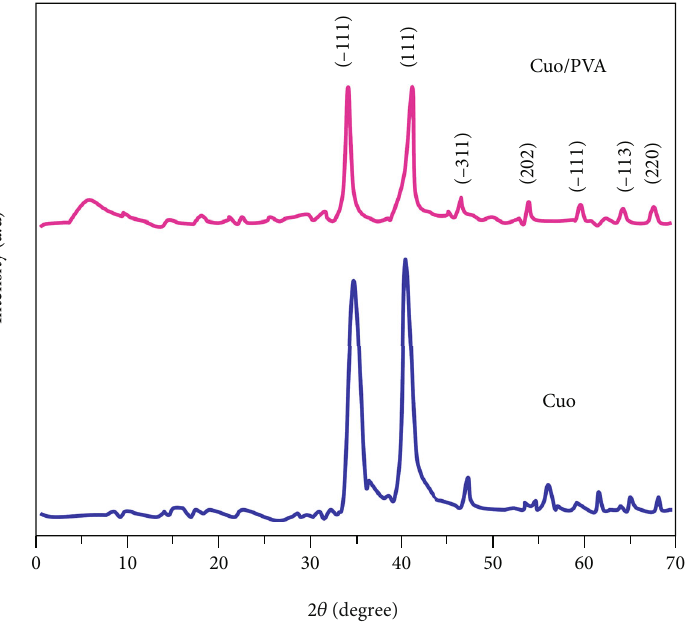
Figure 4: XRD patterns of (a) CuO and (b) CuO/PVA